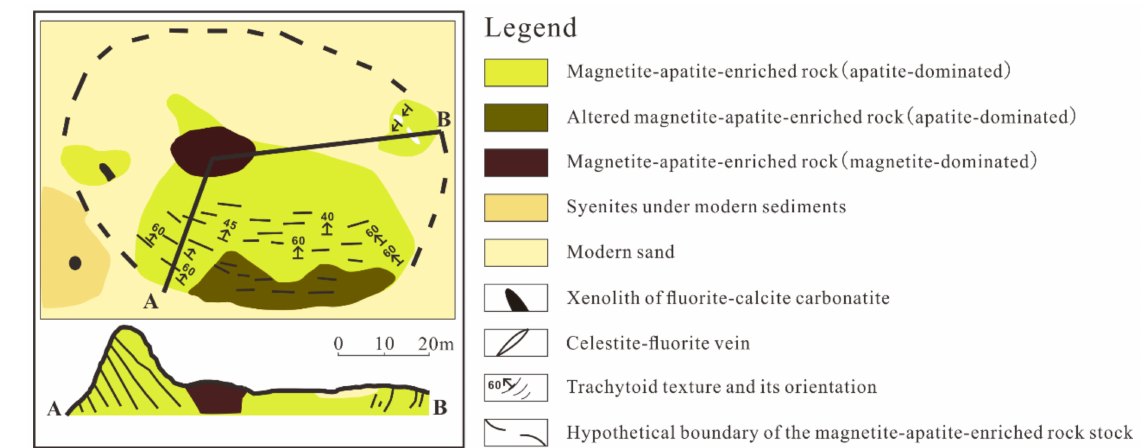
Figure 2. Simplified geological map of magnetite-apatite stock in Mushgai Khudag modified from Nikolenko et al. [10] and Samoilov and Kovalenko